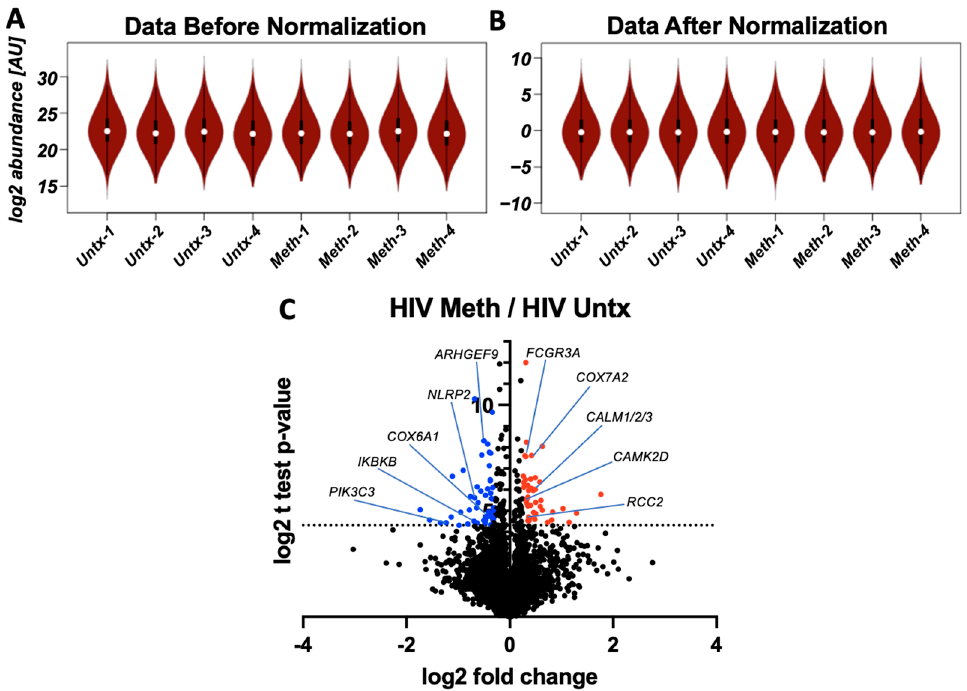
Figure 1. Mass spectrometry proteomics analysis performed on primary human HIV-infected MDM treated with and without methamphetamine (meth, 50 µM) for 24 h from four individuals. ( A ) Distribution of protein abundances across samples after log2 transformation and ( B ) after normalizing the dataset by the center of the distribution, i.e., average. The similarity between the two graphs indicates that the samples were injected at very similar amounts, thus, not requiring advanced normalization steps. ( C ) Volcano plot displaying the log2 fold change ( x -axis) and the log paired t -test p -value ( y -axis) with indicated upregulated proteins (in red, fold change of >1.2, p < 0.05) and downregulated proteins (in blue, fold change of <0.8, p < 0.05).